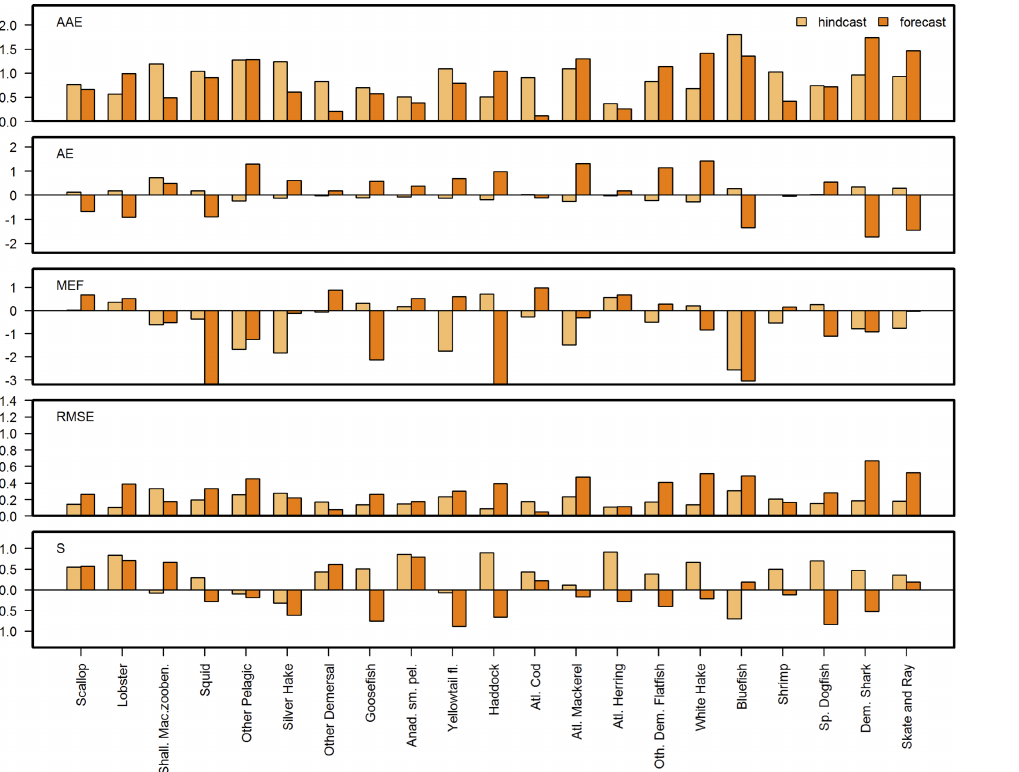
Fig 8. Forecast skill metrics for fisheries landings data. Pairwise comparison of forecast (_f) and hindcast (_h) skill metric performance for 5 skill metrics: MEF, AE, AAE, RMSE and S(pearman rank) Correlation for 21 species of commercial fish and shellfish in the NEUS Atlantis ecosystem model. Y-axis limited to show values between -2 and